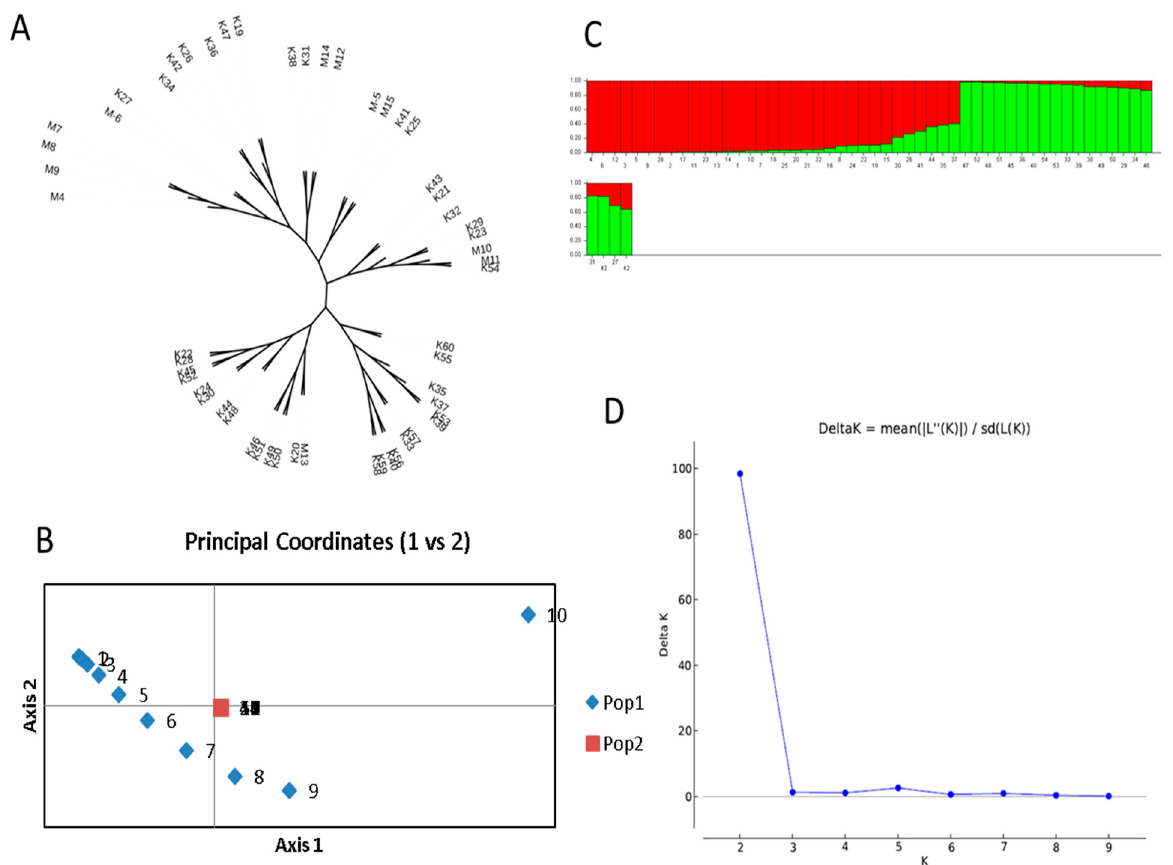
Figure 2. UPGMA, PCoA, and STRUCTURE ( Δ K) analysis of 54 terebinth genotypes. ( A ) Phylogenetic tree constructed using 40 SSR markers. ( B ) PCoA of the 54 samples. ( C ) Population structure of 54 samples estimated from 40 markers using the STRUCTURE program. ( D ) Value of Δ K estimated for the structure analysis of 54 samples ( Δ K = 2).